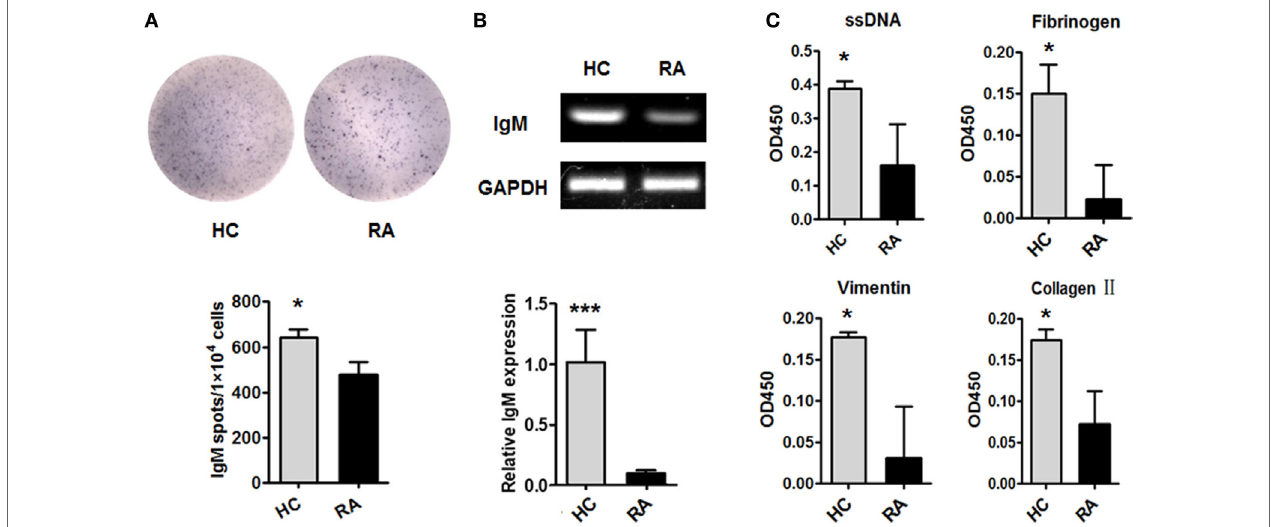
FigUre 3 | Dampened IgM-producing capacities of CD27 + IgD + B cells in rheumatoid arthritis (RA). Flow cytometry-sorted CD27 + IgD + B cells from six healthy donors and five active RA patients (DAS28 > 5.1) were subjected to ELISPOT (a) , PCR and realtime PCR (B) , analyses of IgM. The representative charts as well as the statistical results were shown ( t -test, * P < 0.05, *** P < 0.001). (c) And also, the culture supernatants of equal number of CD27 + IgD + B cells from healthy donors ( n = 6) and active RA patients (DAS28 > 5.1, n = 5) were collected for polyreactivity ELISA against RA autoantigens, including ssDNA, fibrinogen, vimentin, and collagen II ( t -test, * P < 0.05). The results were presented as mean ±